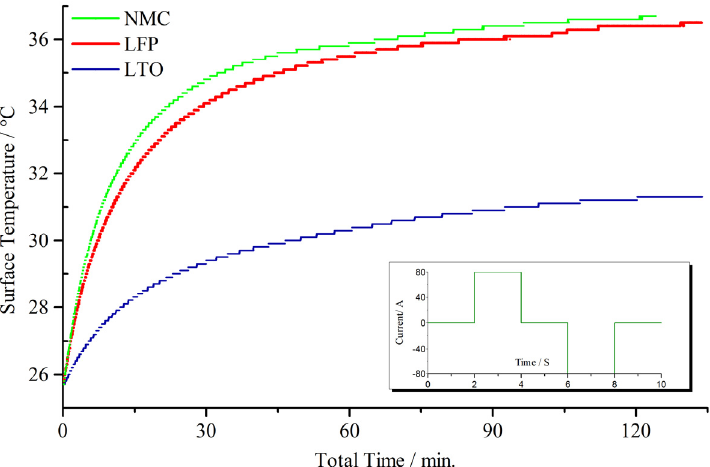
Figure 10. Thermistor based surface temperature profile of NMC, LFP, and LTO cells at 80% SoC during micro pulse cycling (~1000 cycles) at 80 A. Inset shows one single micro pulse